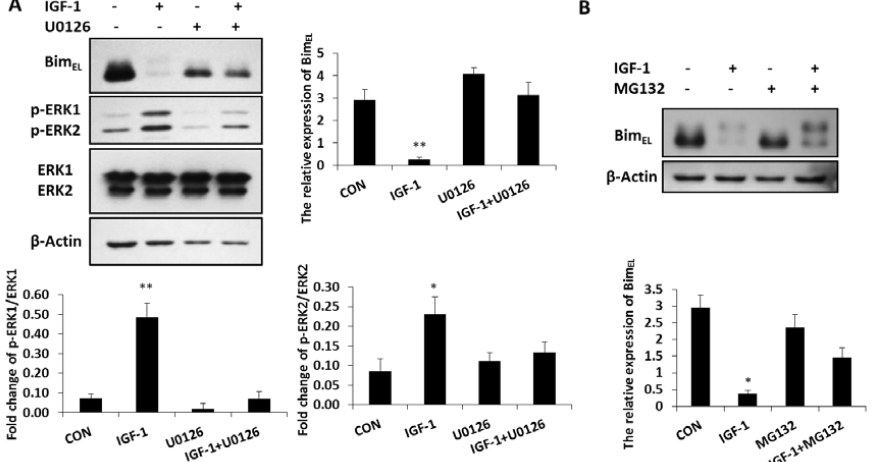
Figure 2. Inhibition of the ERK1/2 pathway impaired the effect of IGF-1 on Bim EL and the proteasome system was related to Bim EL downregulation. ( A ) Granulosa cells were treated with U0126 for 1 h before incubation in the presence of IGF-1 for 24 h. ( B ) Cells were pre-cultured in MG132 for 1 h and treatment with IGF-1 24 h. Bim EL , p-ERK1 / 2, ERK and β -Actin were detected with immunoblotting. Blots were probed with β -Actin to control for loading. Data are shown as means ± SD of at least three separate experiments. * p < 0.05, ** p < 0.01. Int. J. Mol. Sci. 2019 , 20 , x FOR PEER REVIEW